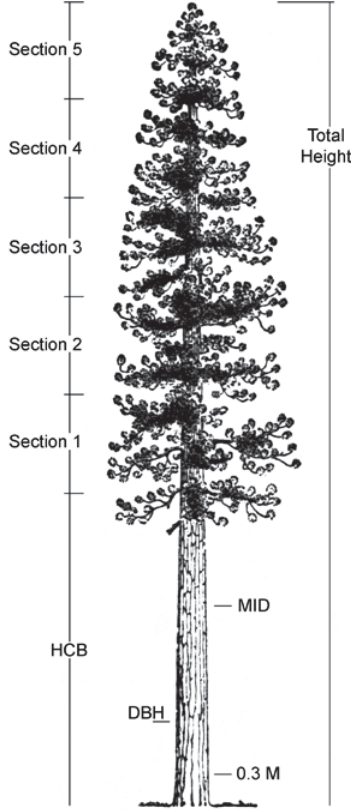
Figure 1. Trees crowns were broken into five sections and portions of the bole were also removed at the stump (0.3 m), breast height and